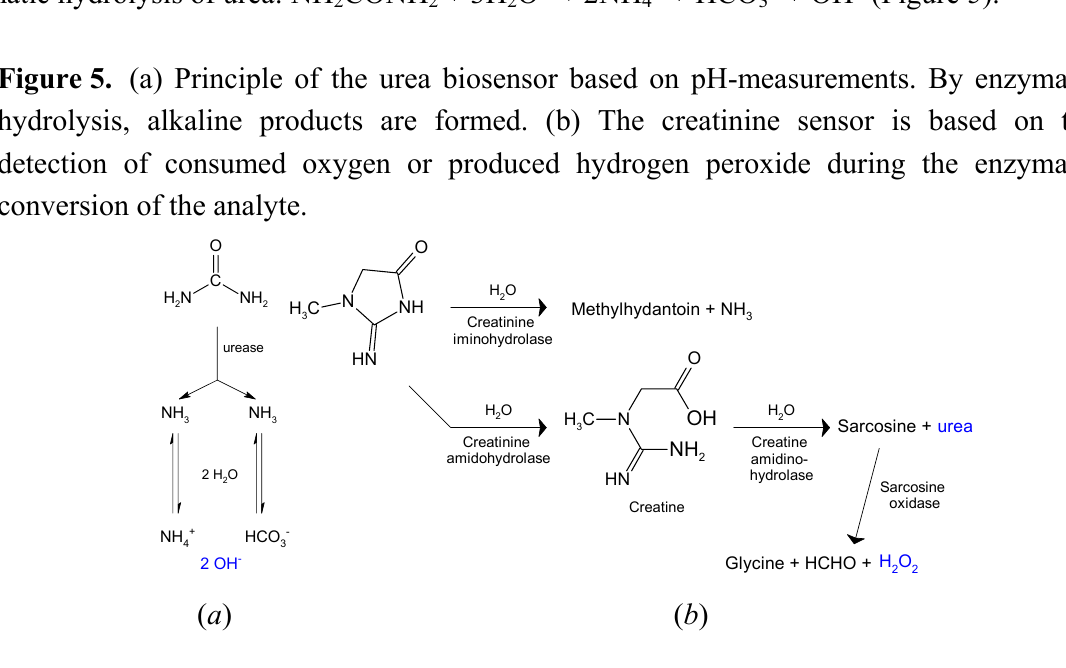
Figure 5. (a) Principle of the urea biosensor based on pH-measurements. By enzymatic hydrolysis, alkaline products are formed. (b) The creatinine sensor is based on the detection of consumed oxygen or produced hydrogen peroxide during the enzymatic conversion of the analyte.